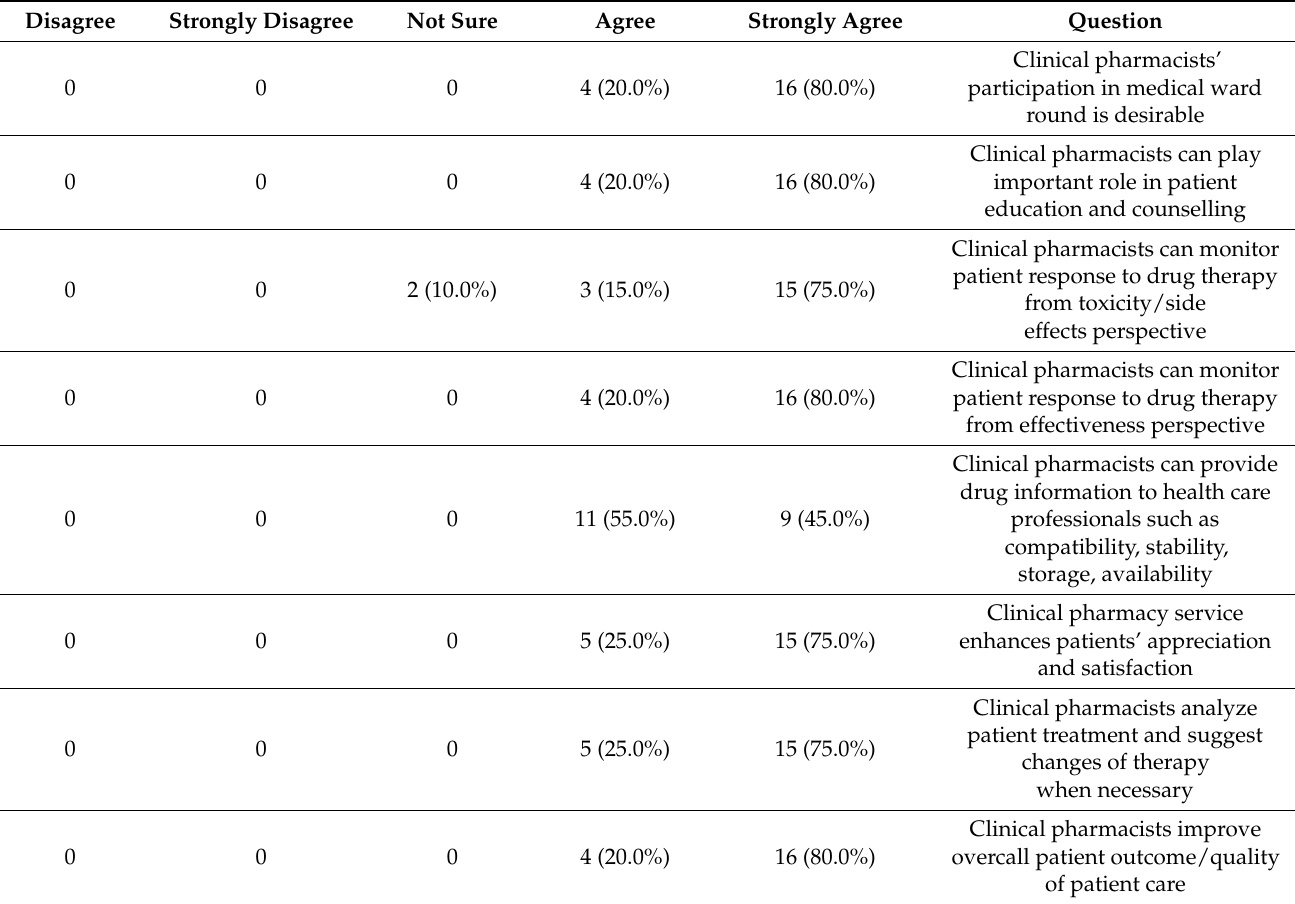
Table 3. Physicians’ responses regarding their level of